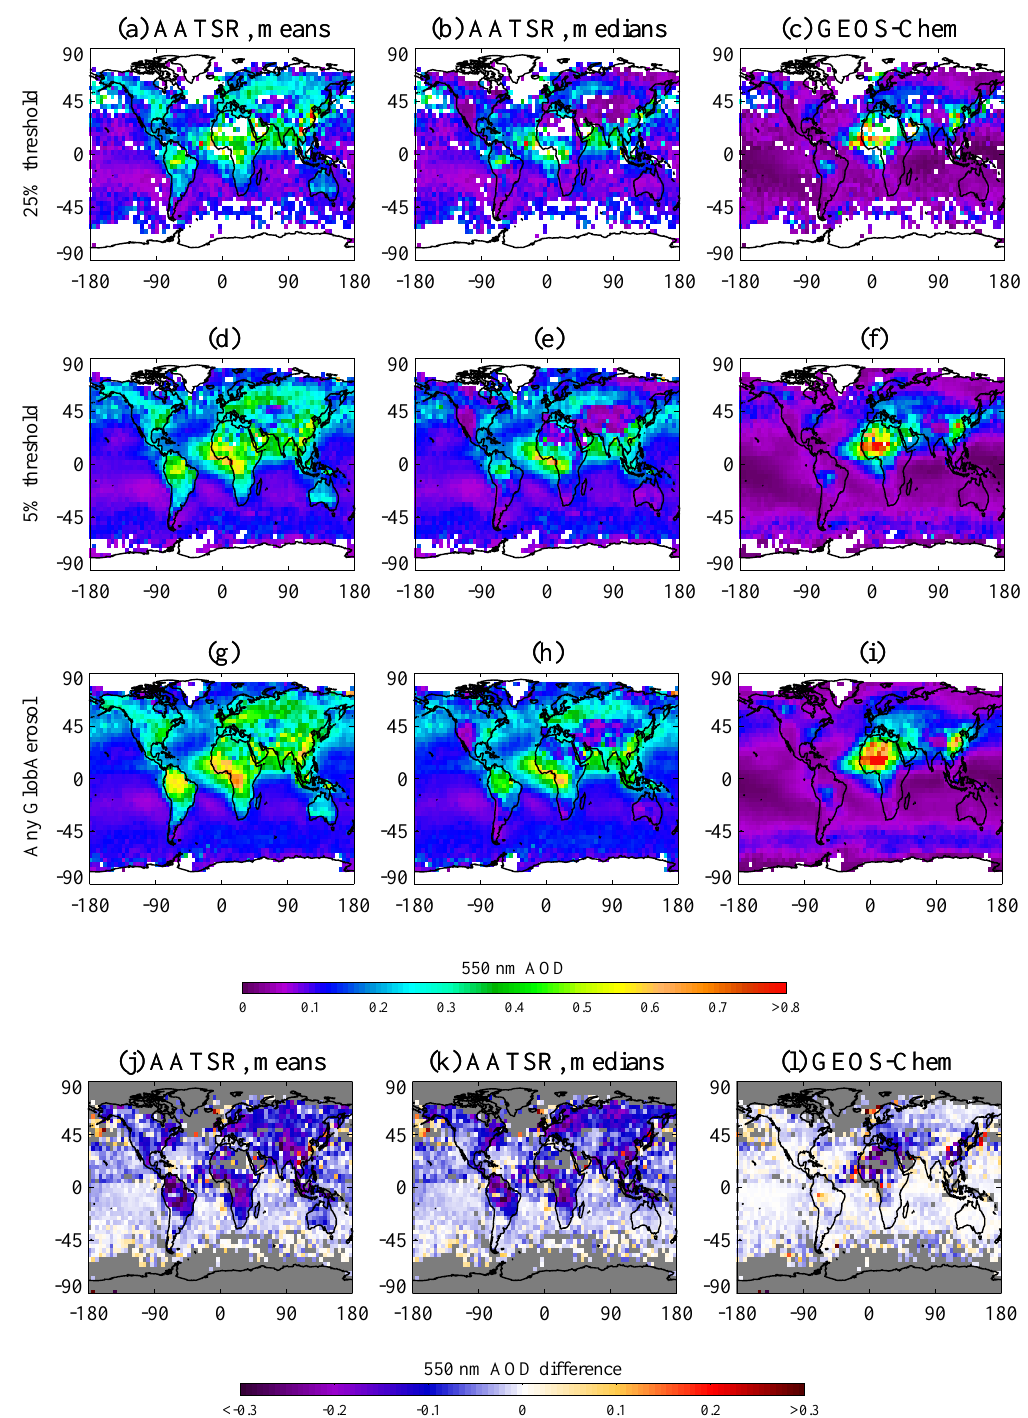
Fig. 7. Comparison between model and satellite annual mean AOD as a function of data sparsity threshold. The left column shows annual fields constructed from GlobAerosol AATSR daily mean fields, the middle column from GlobAerosol AATSR daily median fields, and the right column GEOS-Chem daily AOD fields. The first three rows indicate fields where GEOS-Chem grid cells are at least 25% filled by AATSR data (a, b, c) ; at least 5% filled (d, e, f) ; and contain any GlobAerosol data (g, h, i) . The bottom row shows (j, k, l) the difference in AOD between the 25% and any-data thresholds within each